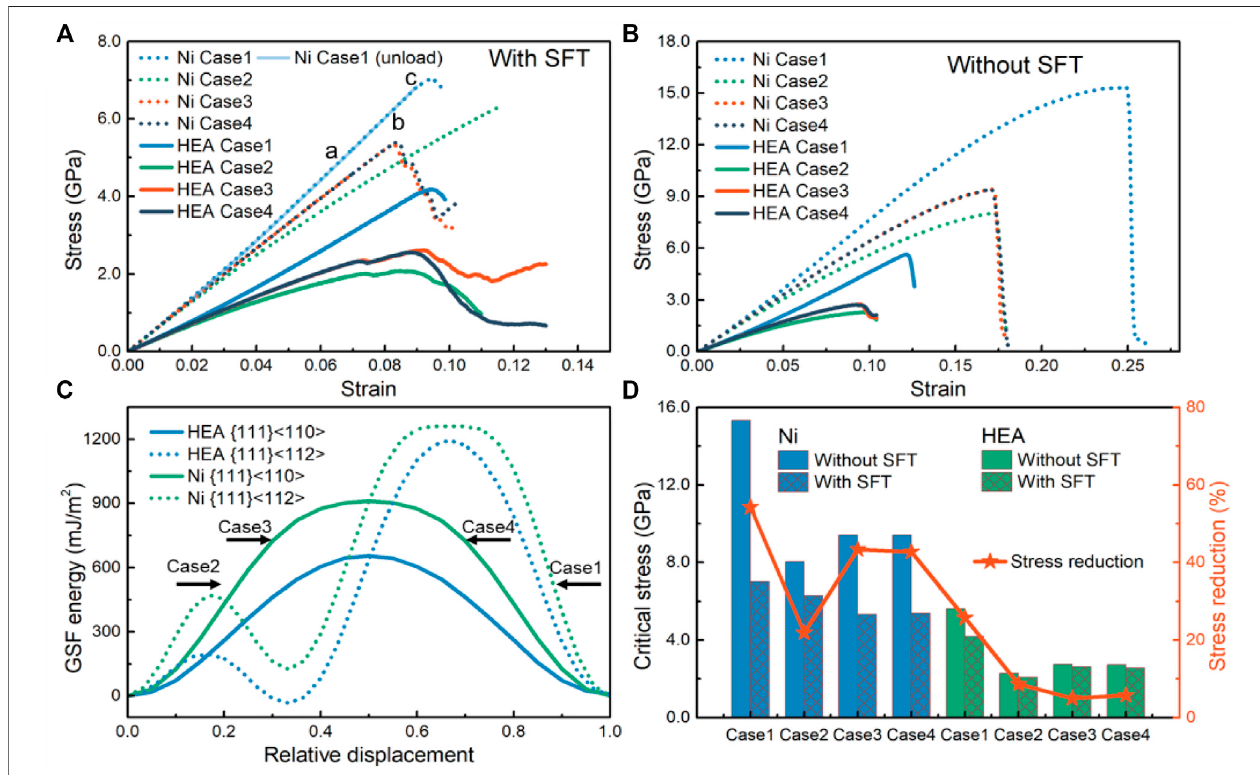
FIGURE8| Shearstress-strain curvesofNiandCoCrFeNiMnHEAsamplesshearedalongfourdirectionsat300 K. (A) withSFT; (B) withoutSFT; (C) Variationsof GSF energies of different slip systems with relative displacement; (D) Comparison of critical shear stress between samples with and without SFT.